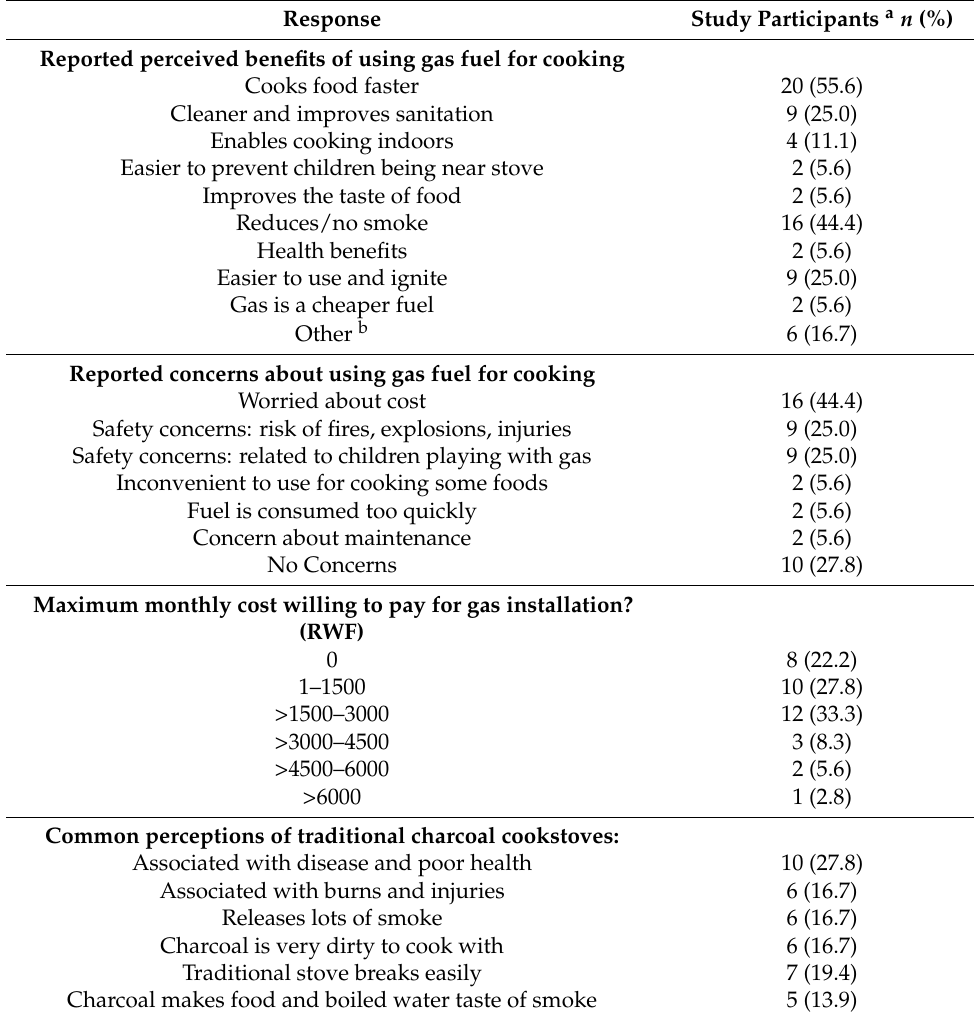
Table 3. Perceptions of using gas fuel and traditional charcoal stoves ( n =